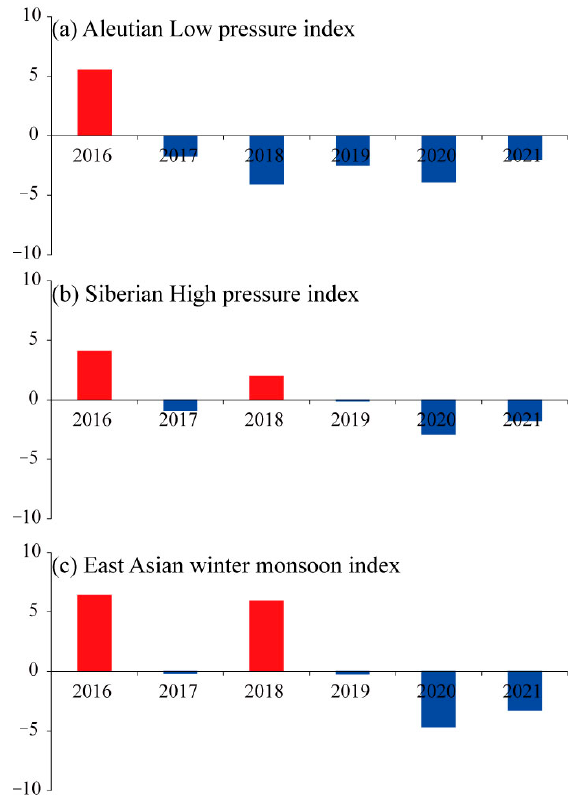
Figure 8. Inter-annual changes in the climate indexes: ( a ) Aleutian low pressure, ( b ) Siberian high pressure, and ( c ) East Asian winter monsoon index.